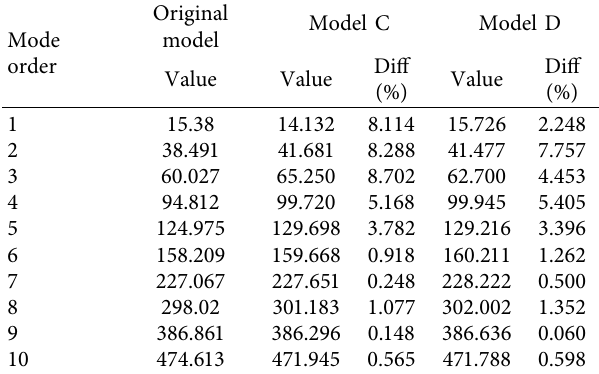
Table 5: The first ten natural frequencies of original model compared with models C and D under F-C boundary conditions.